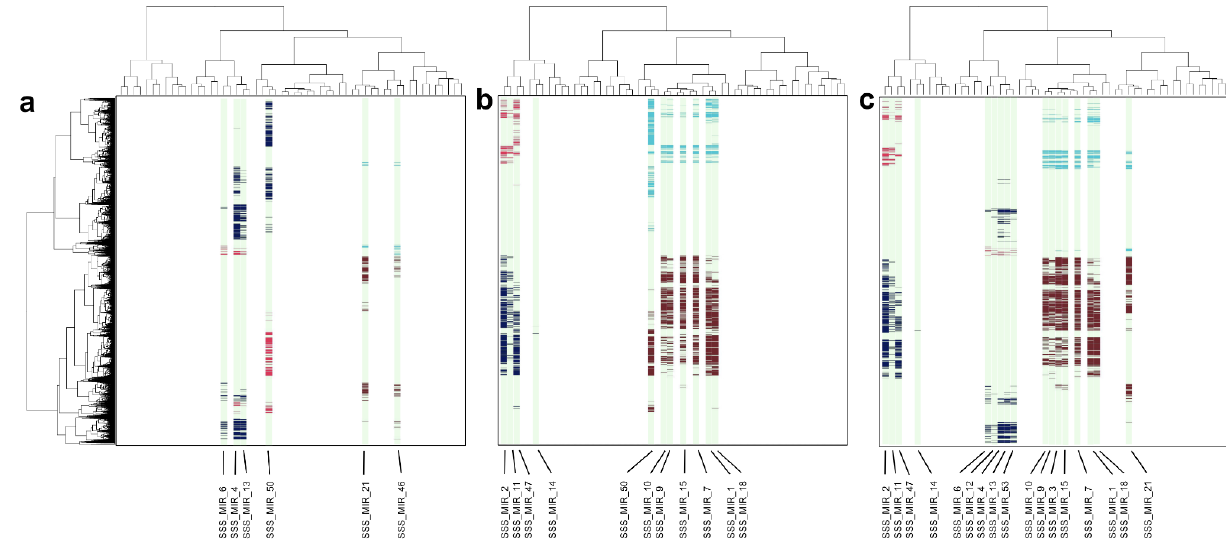
Figure 1. Correlation heatmap of the transcription levels (FC ≥ 1) of protein-coding genes (rows) and microRNAs (columns) across three developmental stages (i.e., early egg (Ee), late egg (Le) and adult female (Af)) of Sarcoptes scabiei upon pairwise comparison. The heatmaps ( a ) Ee vs. Le, ( b ) Le vs. Af and ( c ) Ee vs. Af display low ( ↓ , dark blue and brown) and high ( ↑ , light blue and red) mRNA transcription of genes associated with particular miRNAs (green lanes) (cf. Tables 1 and 2). Vertical and horizontal dendrograms display similar transcription levels of protein-coding genes and miRNAs, respectively.